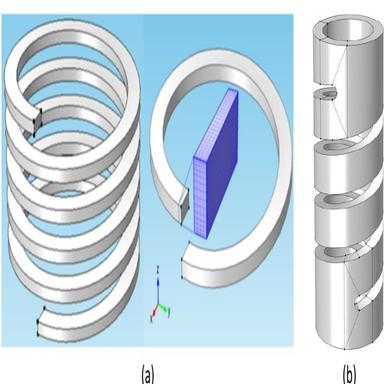
Finite element simulation models of the helical spring (a) single coil model, (b) full spring model.